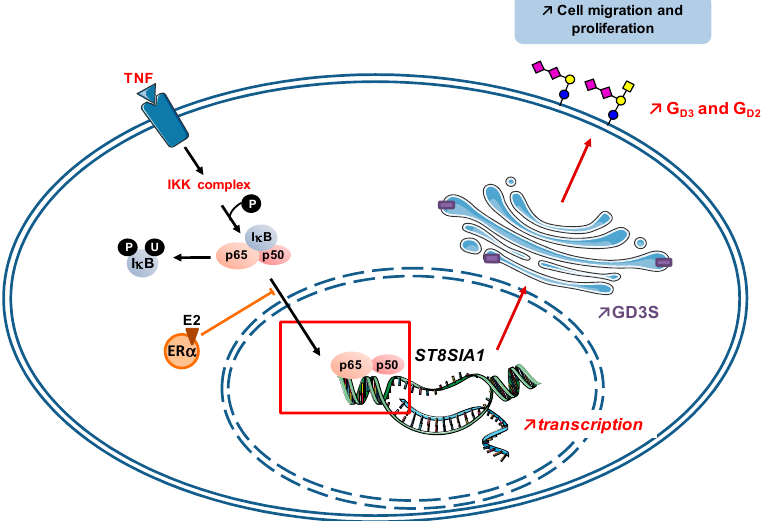
Figure 4. Mechanism of estradiol-dependent repression of GD3S in ER-positive breast cancer cells. GD3S gene ( ST8SIA1 ) transcription is activated by NF- κ B pathway upon TNF stimulation, leading, in ER-negative breast cancer cells, to an increased expression of GD3S in the Golgi apparatus and disialoganglioside (G D3 and G D2 ) at the cell surface, increasing cell migration and proliferation. In ER-positive breast cancer cells, estradiol (E2)-ER α complex represses the TNF-induced up-regulation of GD3S by inhibiting NF- κ B nuclear translocation [105].